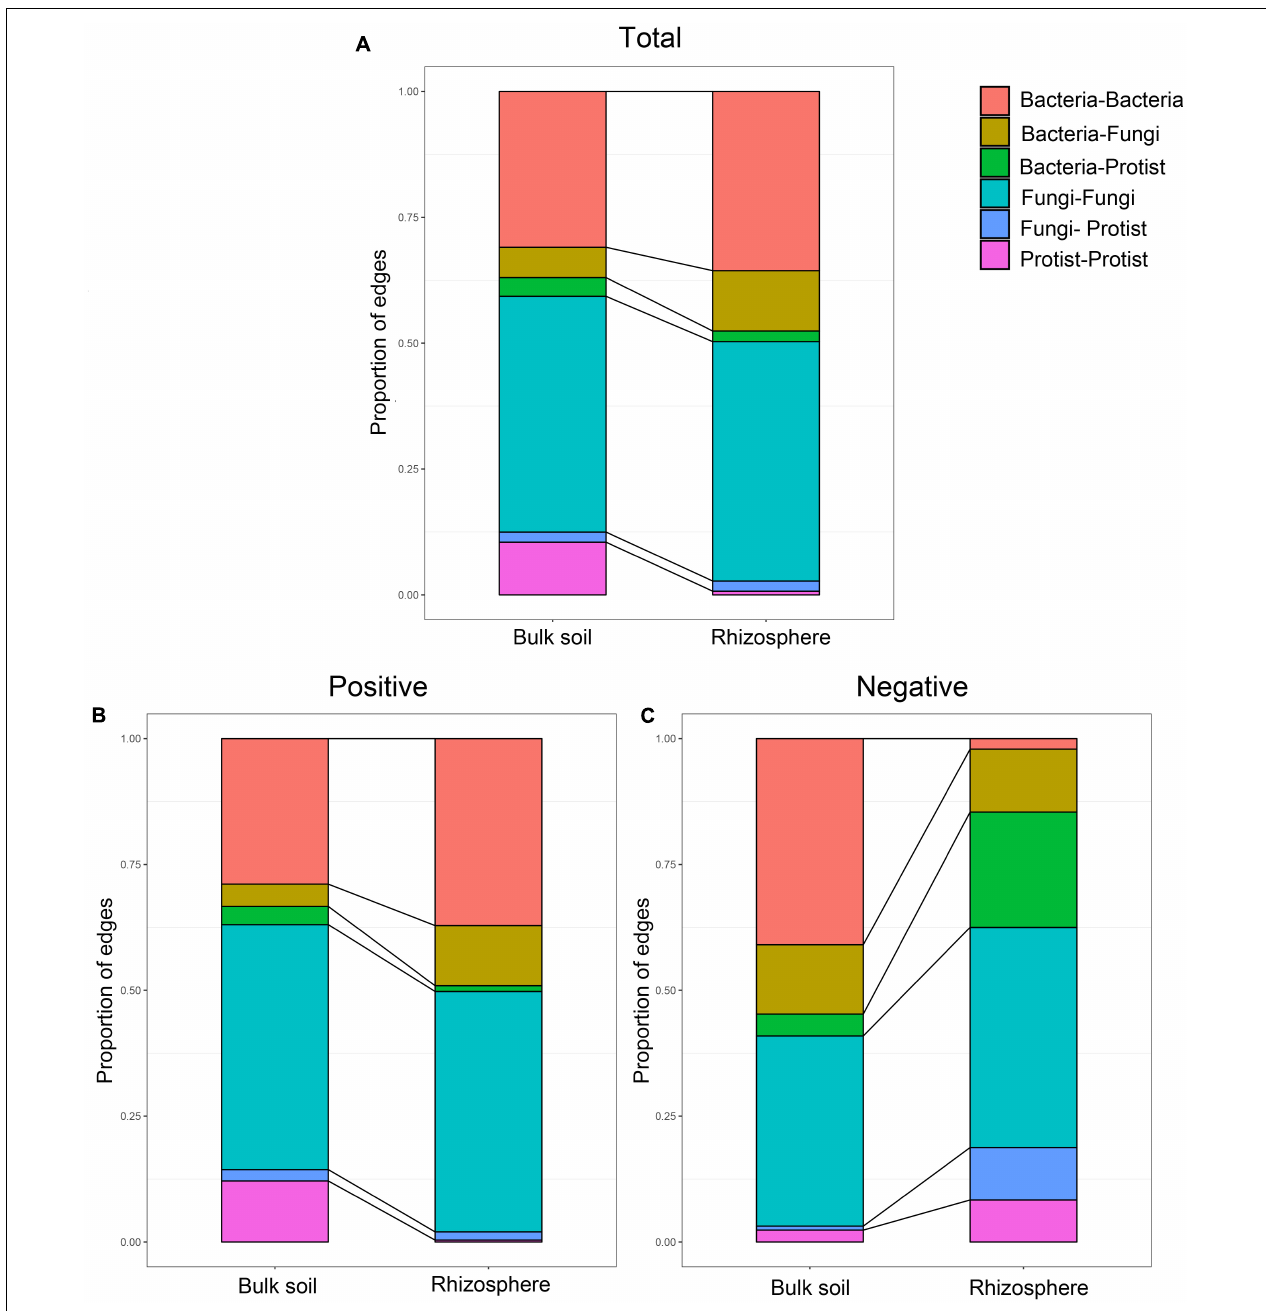
FIGURE 7 | Relative abundance of each type of edge in the co-occurrence networks of the microbial communities in bulk soil and soybean rhizosphere, (A) for all edges, (B) for positive edges, and (C) for negative